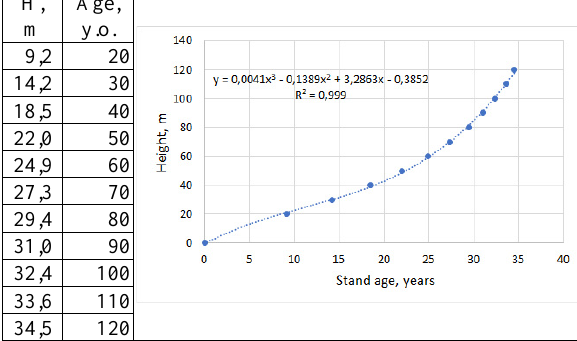
Figure 4. Correlation between spruce stand height and age For better perception obtained data are ranked in ascending order and are colored from red (the lowest and fastest growing trees) to blue (not increasing in height) (Figure 5).